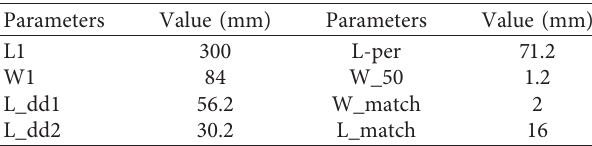
Figure 7: Geometry of the proposed antenna. (a) Antenna array. (b) Antenna subarray. Table 2: Parameters of the antenna subarray.